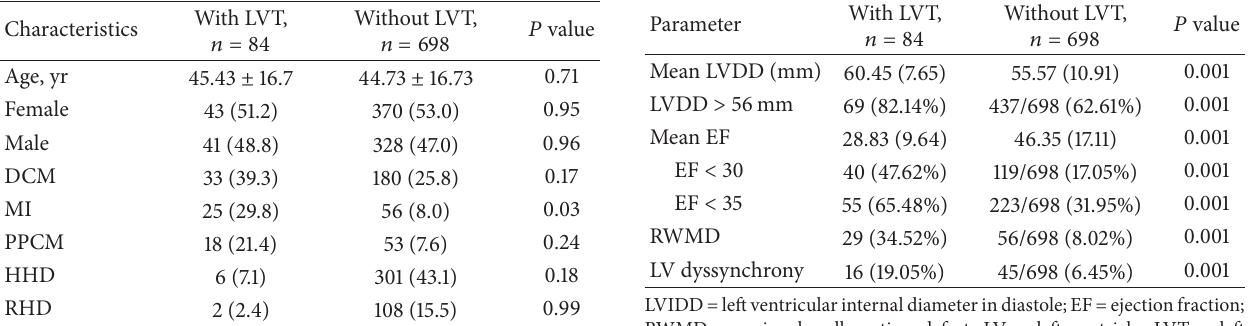
Table 2: Echocardiographic profiles of subjects with and without left ventricular thrombus.